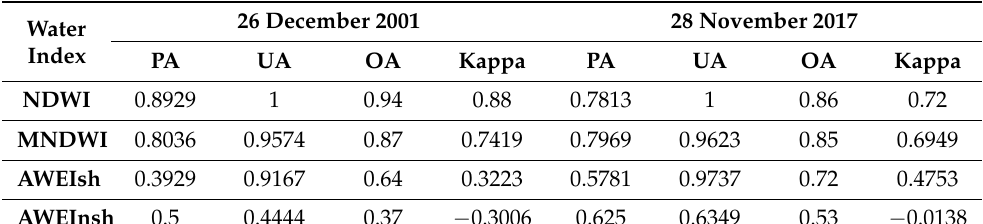
Table 9. Qishan River: Accuracy of spectral water body indices in terms of water body extraction on different dates.